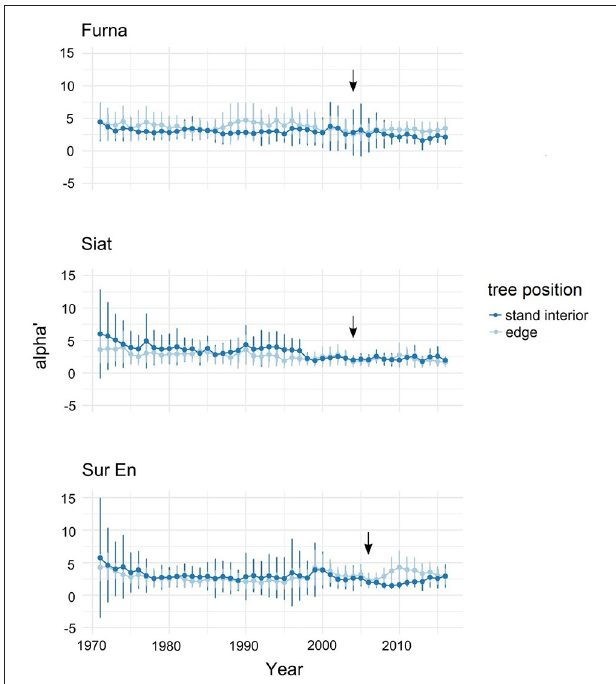
FIGURE 4 | Annual allometric slope α ’ (alpha’ ± standard deviation) in edge and stand interior trees at the study sites Furna, Siat, and Sur En. Alpha’ is calculated according to Equation (2) for the period 1971–2016. Arrows indicate the year of strip